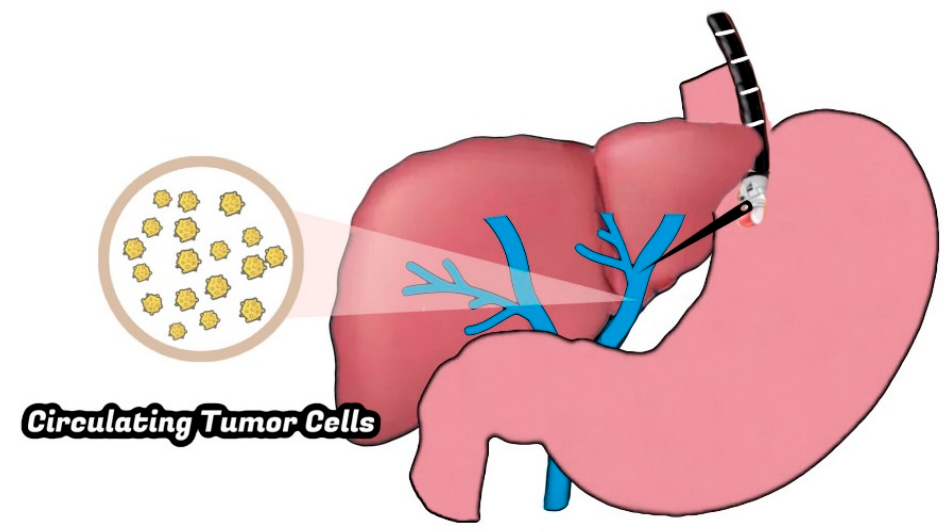
Figure 2. EUS-guided portal venous sampling for circulating tumor cells.